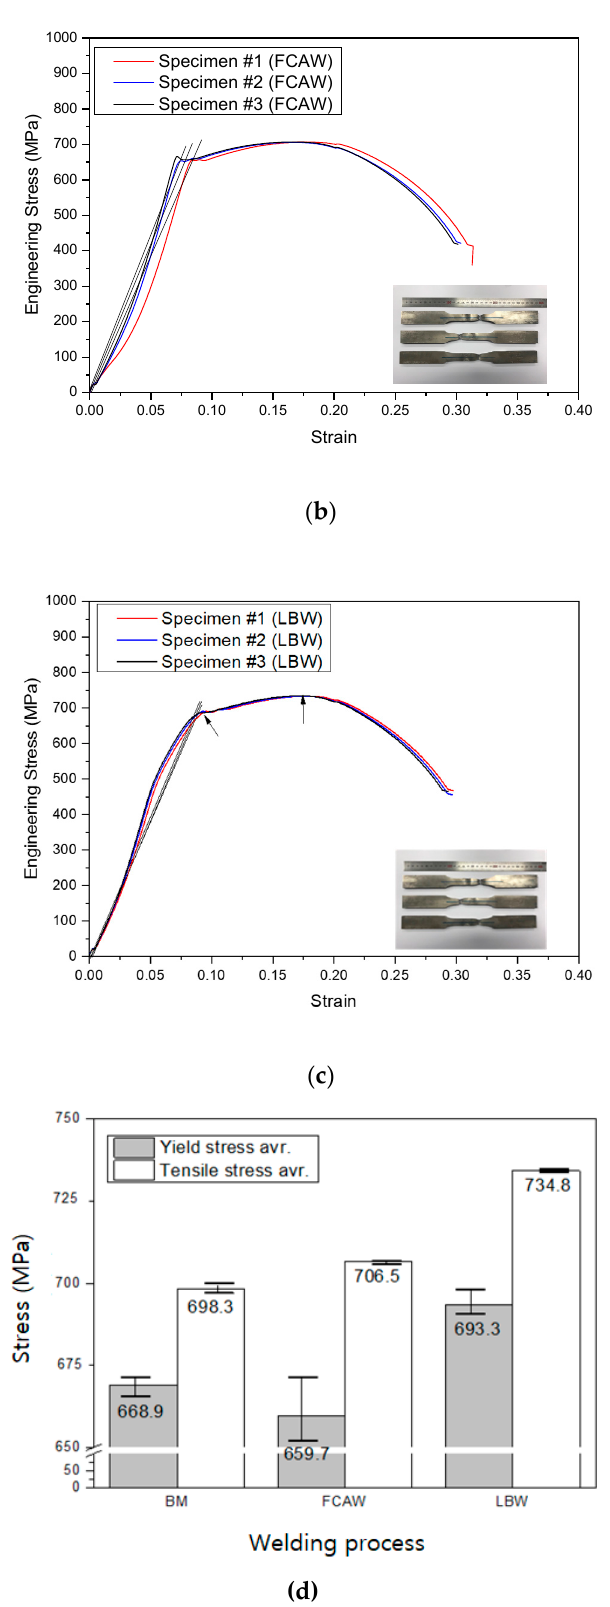
Figure 6. Stress–strain curve and comparison of yield/tensile strength. ( a ) Stress–strain curve of base metal; ( b ) stress–strain curve of FCAW weldment; ( c ) stress–strain curve of LBW weldment; ( d ) comparison yield/tensile strength.